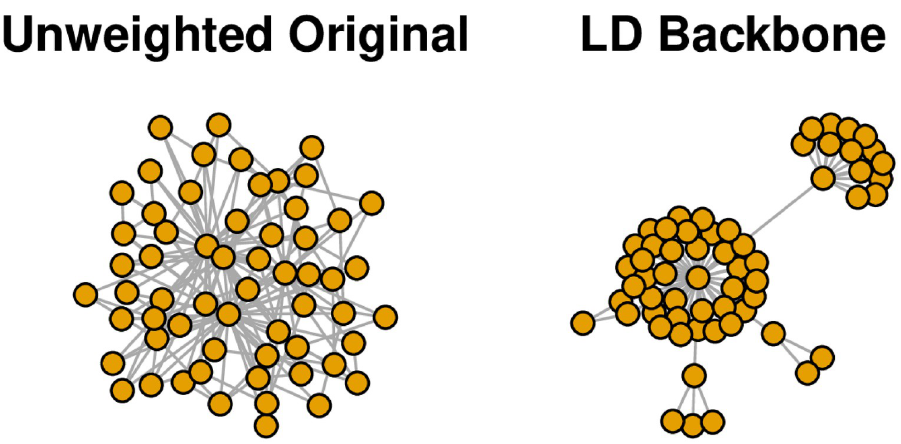
Fig 7. Extracting the backbone of an unweighted network with embedded hub/spoke structure (toy example).